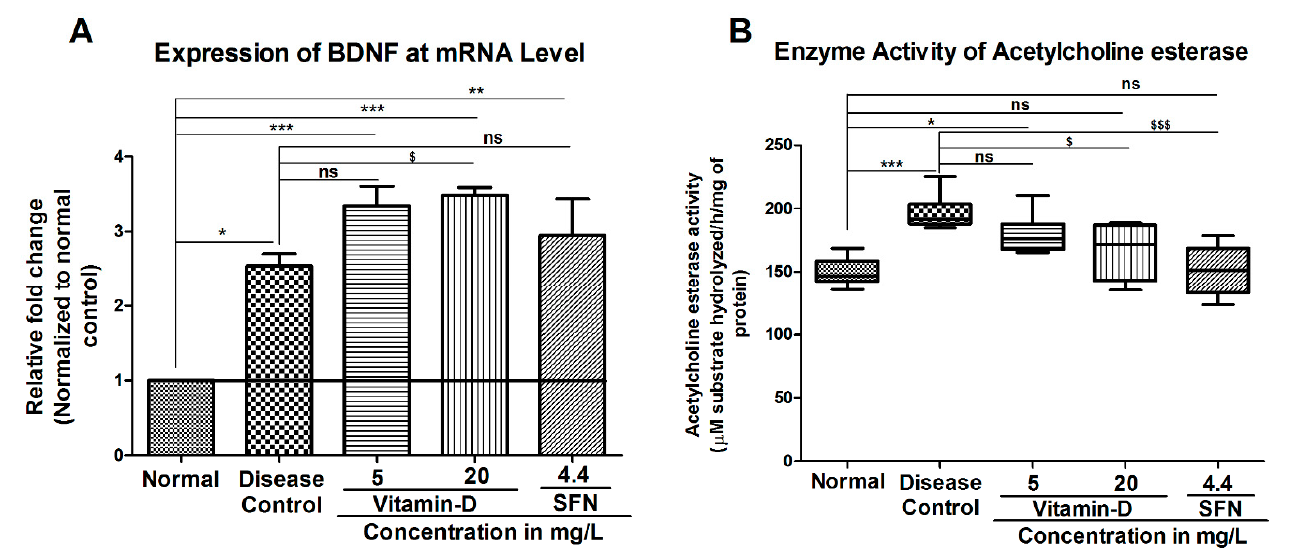
Figure 5. Vitamin D and SFN Modulated the Brain-Derived Neurotrophic Factor (BDNF) and Acetylcholine Esterase Activity. ( A ) Hyperglycemia has induced BDNF expression in zebrafish: A significant increase in the BDNF mRNA was observed in zebrafish residing in 111 mM glucose. Treatment with vitamin D and SFN had no significant difference in BDNF mRNA when compared to disease control. “***”, “**” & “*” Represent the significant differences in BDNF mRNA expression when compared with healthy control group with p < 0.0001, <0.001 & <0.05. ‘’$” Represents a significant difference in BDNF expression when compared with disease control with p < 0.05 and “ns” represents a non-significance compared to disease control. ( B ) Twenty milligram per liter (20 mg/L) vitamin D and SFN reduced the diabetes induced acetylcholine esterase activity. Hyperglycemia significantly increased the activity of acetylcholine esterase in zebrafish. “***” & “*” Represents significant difference in acetylcholine esterase activity between the groups when compared with normal control with p < 0.0001 & <0.05 respectively. Treatment with 20 mg/L vitamin D and SFN reduced the hyperglycemia induced acetylcholine esterase activity “$” & “$$$” represents significant difference in acetylcholine esterase activity between the groups when compared with disease control with p < 0.05 & <0.0001 respectively. “ns” represents non-significant difference. Data represents mean ± SEM. Data were analyzed statistically by one-way ANOVA, followed by Tukey ‘s post hoc test, considering p < 0.05 as significant. The specific activity of acetylcholine esterase was reported as a micromole of thiocholine released per hour per milligram of protein.